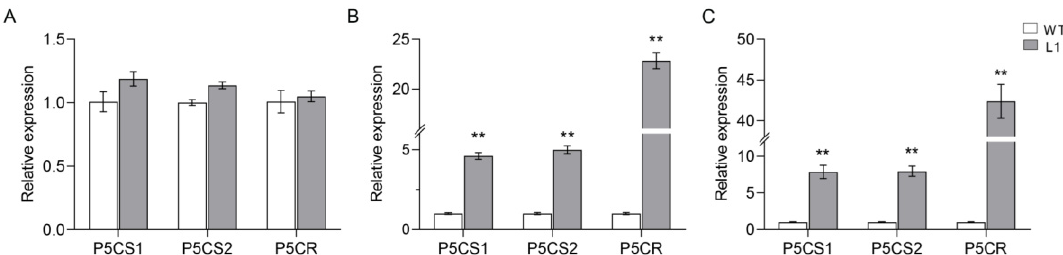
Figure 8. Expression of proline synthesis-related enzyme genes in Arabidopsis thaliana leaves under different treatment conditions. Relative expression levels of each gene ( A ) under unstressed conditions; ( B ) under NaCl stress; ( C ) under PEG stress. The data were means ± SD from three independent replications. The asterisks above the columns indicate a significant difference compared to WT (** p < 0.01).